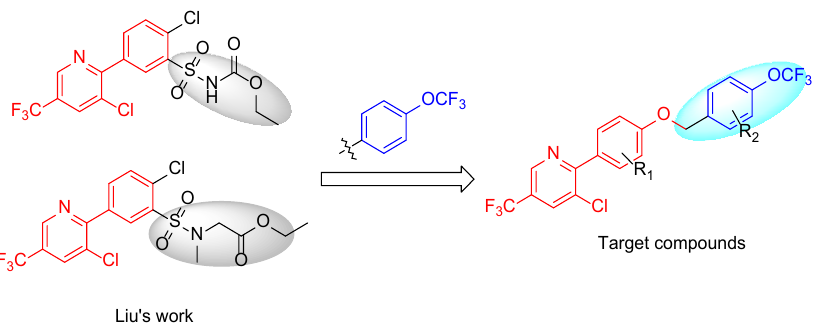
Figure 2. Design strategy of target compounds.